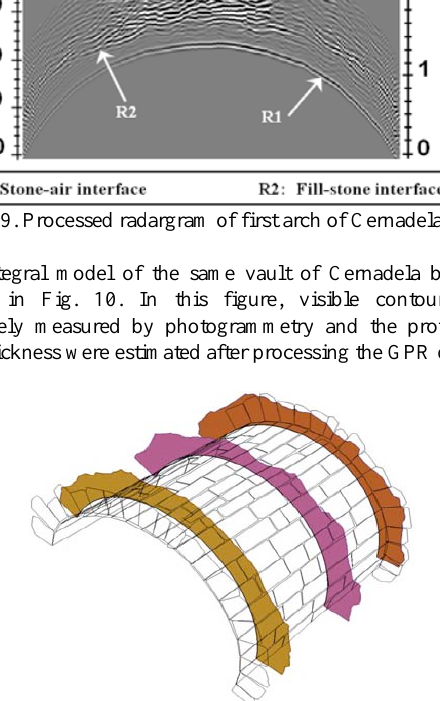
Figure 10. 3D model of one of the vaults of Cernadela Bridge: visible contours acquired by photogrammetry and voussoir’s thickness at inner parts of the vault by